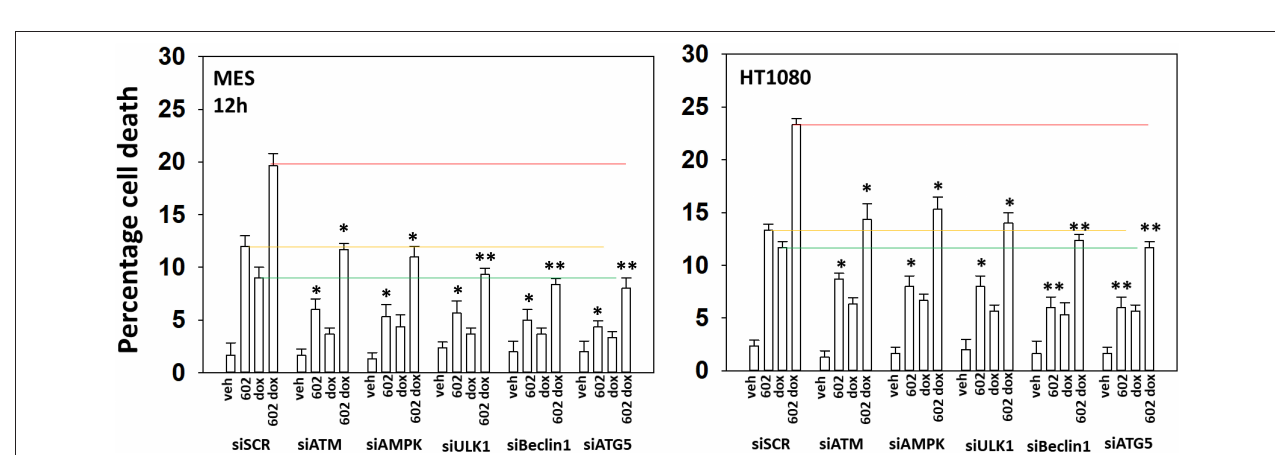
FIGURE 4 | GZ17-6.02 and doxorubicin interact to activate c-MET. HT1080 human sarcoma cells were treated with vehicle control, GZ17-6.02 (2 µ M final curcumin), doxorubicin (200nM) or the drugs in combination for 3 and 6h. Cells were fixed in place and immunostained to detect the total expression and the total phosphorylation of the indicated proteins. The phosphorylation of each phosphoprotein was corrected for total protein expression; HDAC6 had its expression corrected using invariant ERK2 expression. ( n = 3 + /–SD) * p < 0.05 less than vehicle control; # p < 0.05 greater than vehicle control.